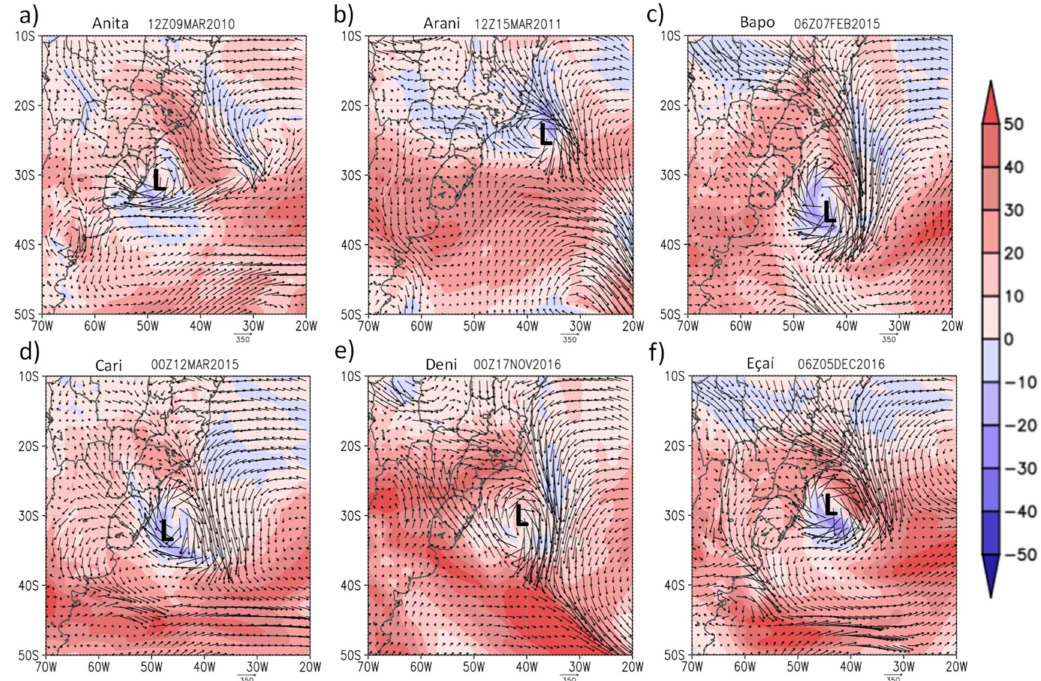
Figure 7. Vertical wind shear (m · s − 1 ) in the layer 200–850 hPa (200 minus 850 hPa; shaded) and the vertically integrated horizontal moisture flux (vectors in kg · m − 1 · s − 1 ; black lines) at the maturity phase of the six subtropical cyclones: ( a ) Anita, ( b ) Arani, ( c ) Bapo, ( d ) Cari, ( e ) Deni and ( f ) Eça í